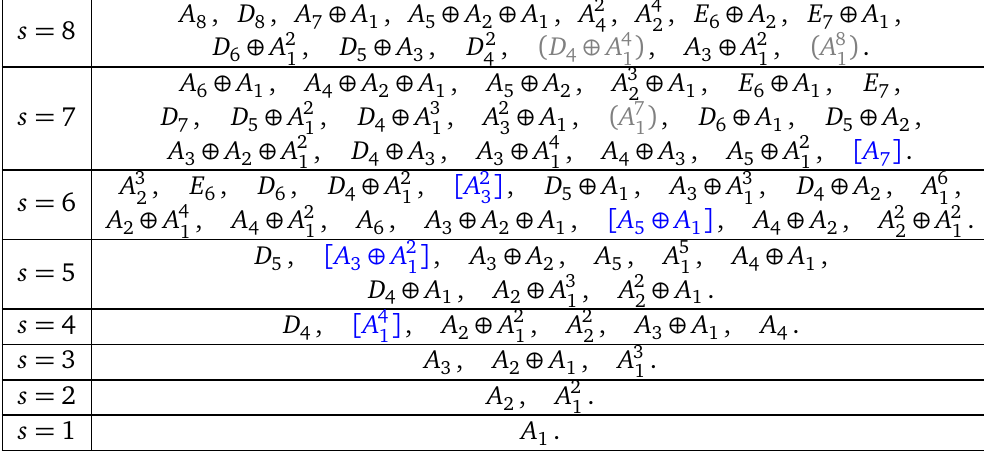
. The sublattices that admit two 8